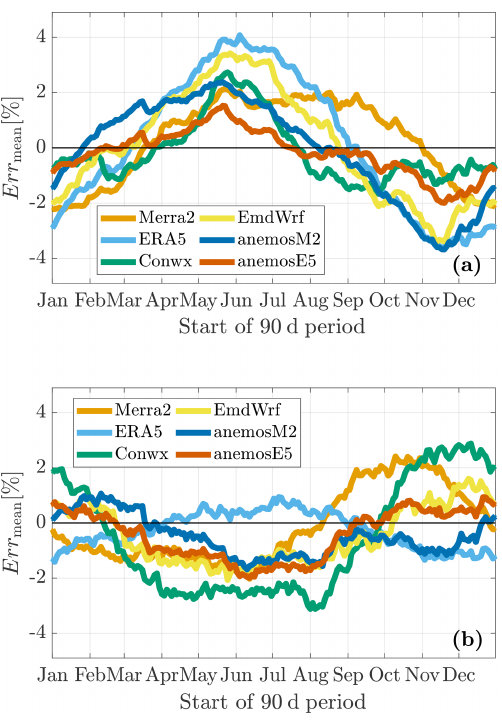
Figure 7. Temporal variations during the year of the bias in mean wind speed using the (a) variance ratio and (b) linear regression with residuals